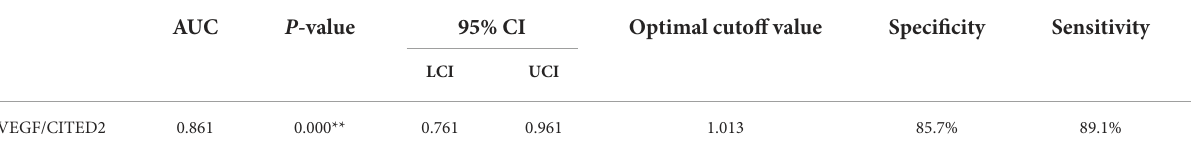
TABLE 6 ROC analysis of the poor collateral circulation in